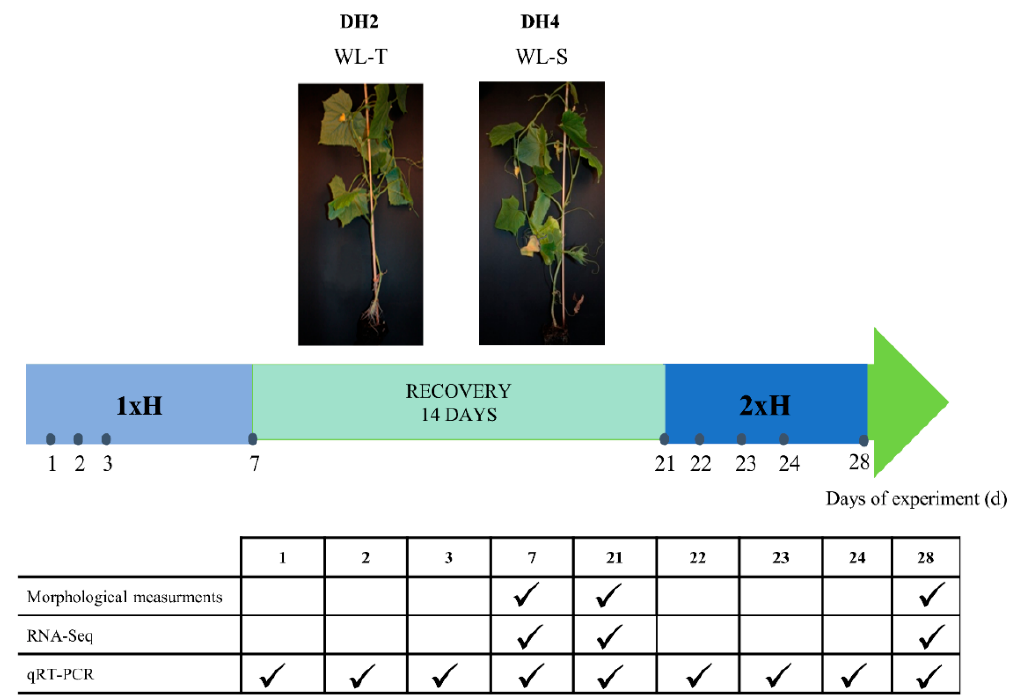
Figure 1. Scheme describing the experiment duration and time-points of sample collection for morphological parameter measurements, RNA-Seq and qRT-PCR. The image presents double haploid (DH) lines of 1xH treatment i.e., WL-T DH2 and WL-S